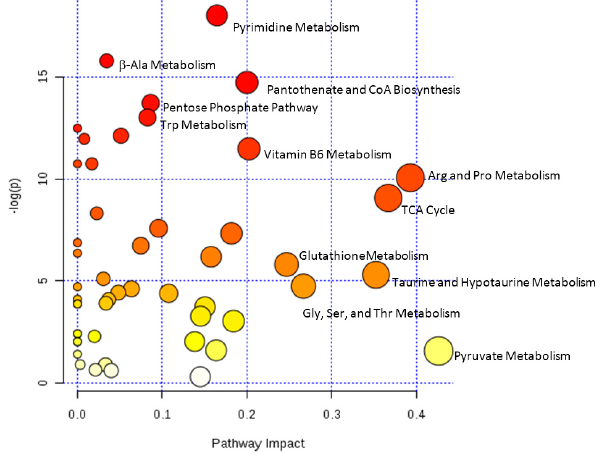
Figure 2. Metabolome view from pathway analysis performed using MetaboAnalyst. Select pathways with high pathway impact and/or high p -value are labeled.